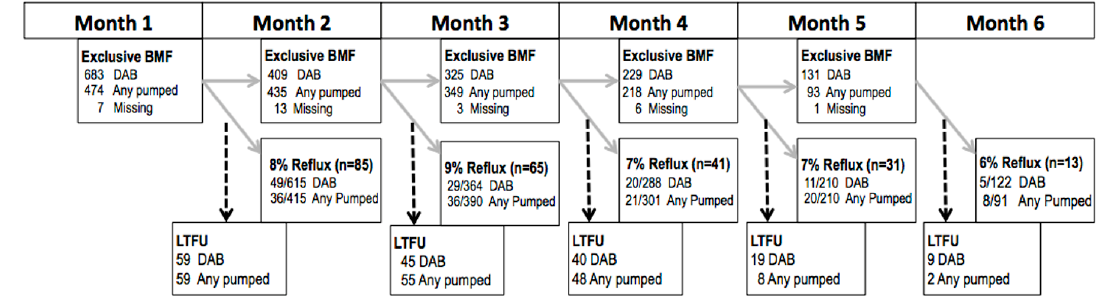
Figure 1. Repeated analysis of the association between exclusive breast milk feeding mode and reflux, with feeding mode lagged one month, for exclusively breast milk fed infants whose mothers participated in the Infant Feeding Practices Survey II (IFPS II) in the U.S., 2005–2007. BMF = breast milk feeding; DAB = direct at breast; LTFU = lost to follow up; Missing observations = crude (n = 127; 3.8%) and adjusted (n = 224; 6.8%).